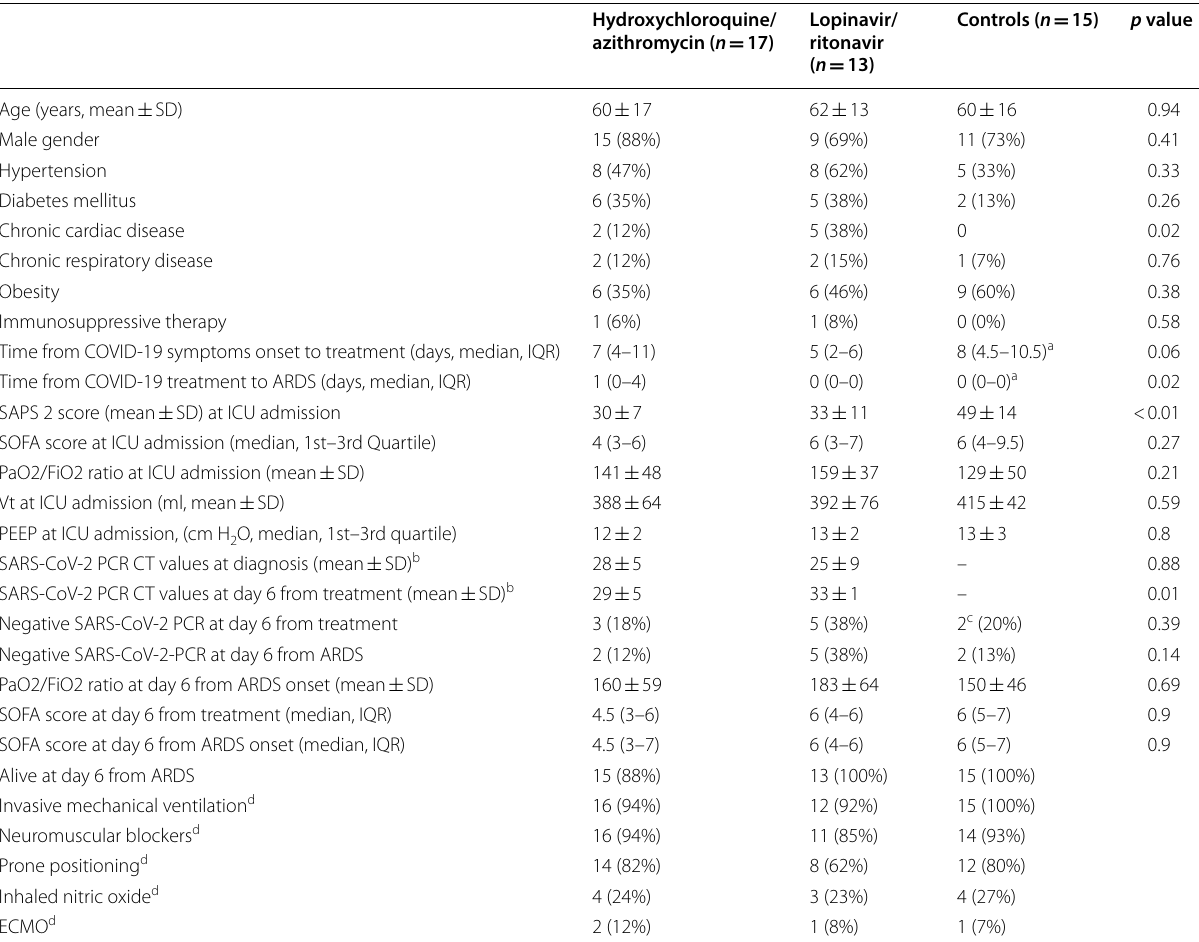
Table 1 Characteristics and main